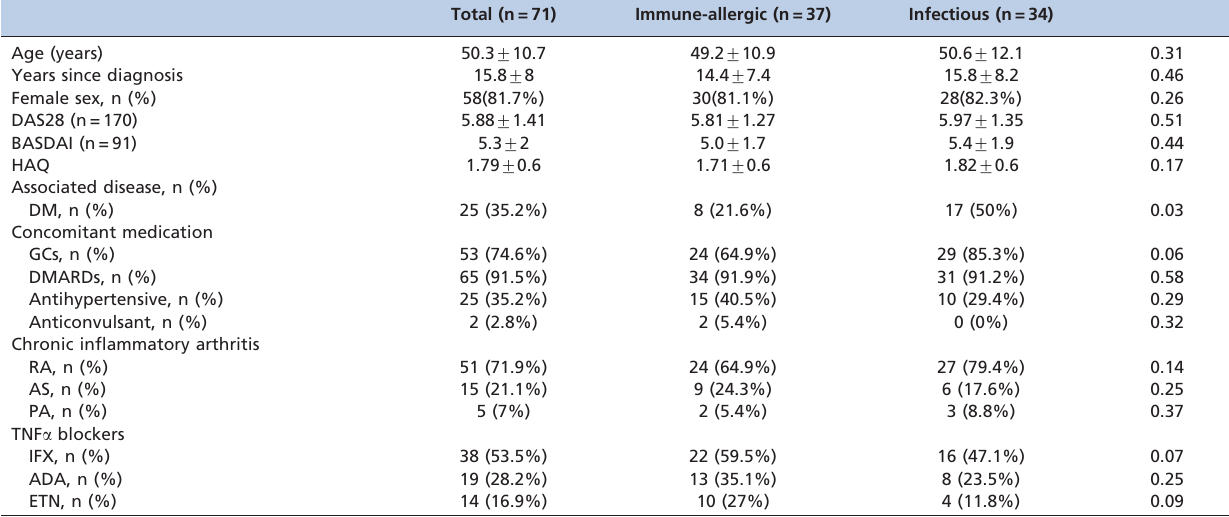
Table 3 - Clinical characteristics of the 71 CAEs according to the mechanism involved (immune-allergic vs .